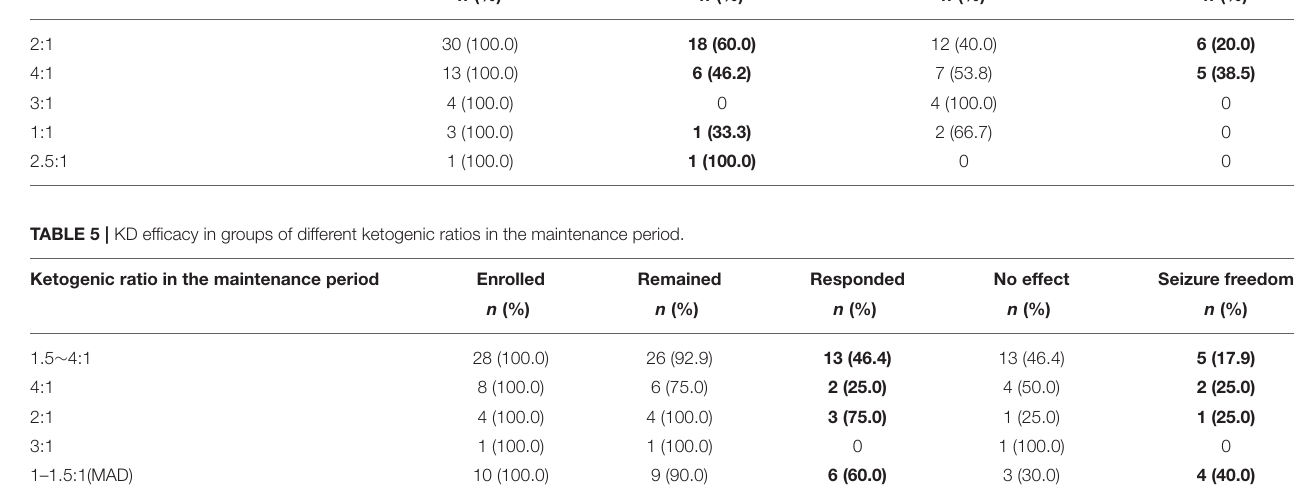
TABLE 4 | KD efficacy in groups of different ketogenic ratios at initiation. Ketogenic ratio at KD initiation